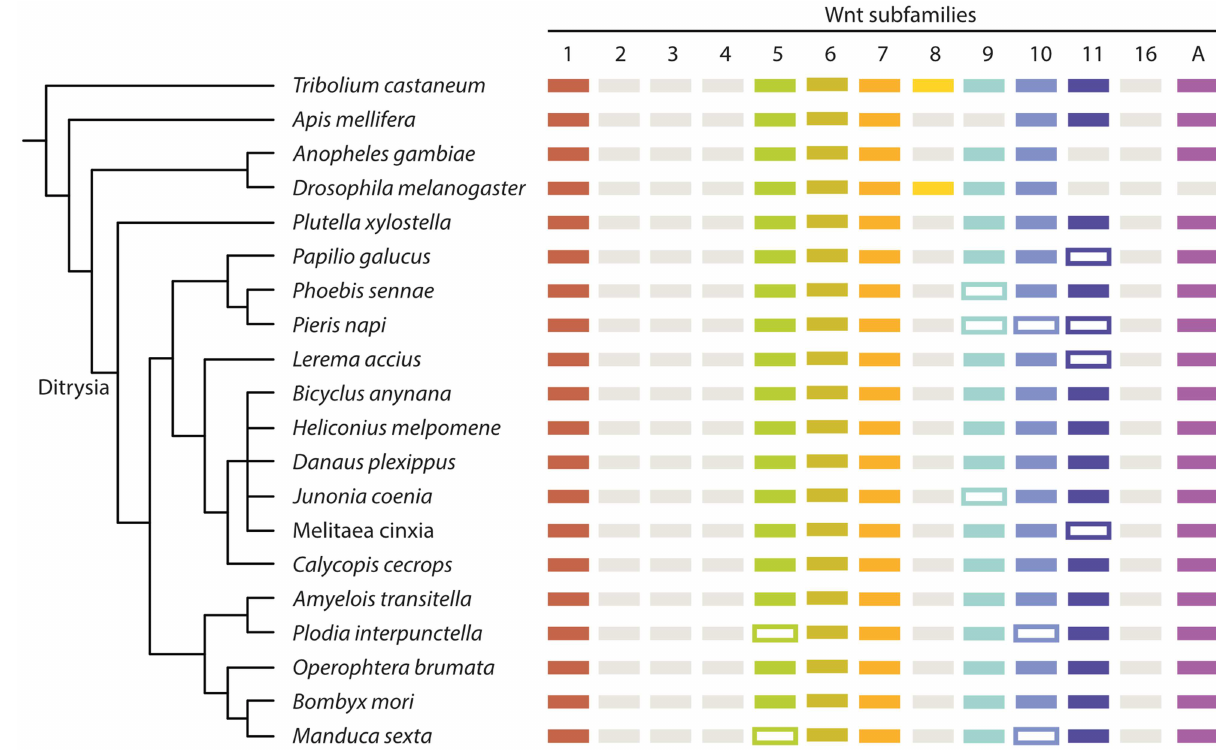
FIGURE 3 | Summary of the Wnt repertoire in all examined insect species. Simplified cladogram based on previously published phylogenetic data (Kawahara and Breinholt, 2014; Mitter et al., 2017) with the presence of Wnt genes indicated by colored boxes. Framed boxes indicate the potential presence of a Wnt ligand, but absence from the used dataset. Gray boxes indicate a loss of a Wnt subfamily. Ag, A. gambiae; Tc, T. castaneum; Am, A. mellifera; Dm, D. melanogaster; Px, P. xylostella; Pg, P. glaucus; Ps, P. sennae; Pn, P. napi; La, L. accius; Ba, B. anynana; Hm, H. melpomene; Dp, D. plexippus; Jc, J. coenia; Mc, M. cinxia; Cc, C. cecrops; At, A. transitella; Pi, P. interpunctella; Ob, O. brumata; Bm, B. mori; Ms, M. sexta